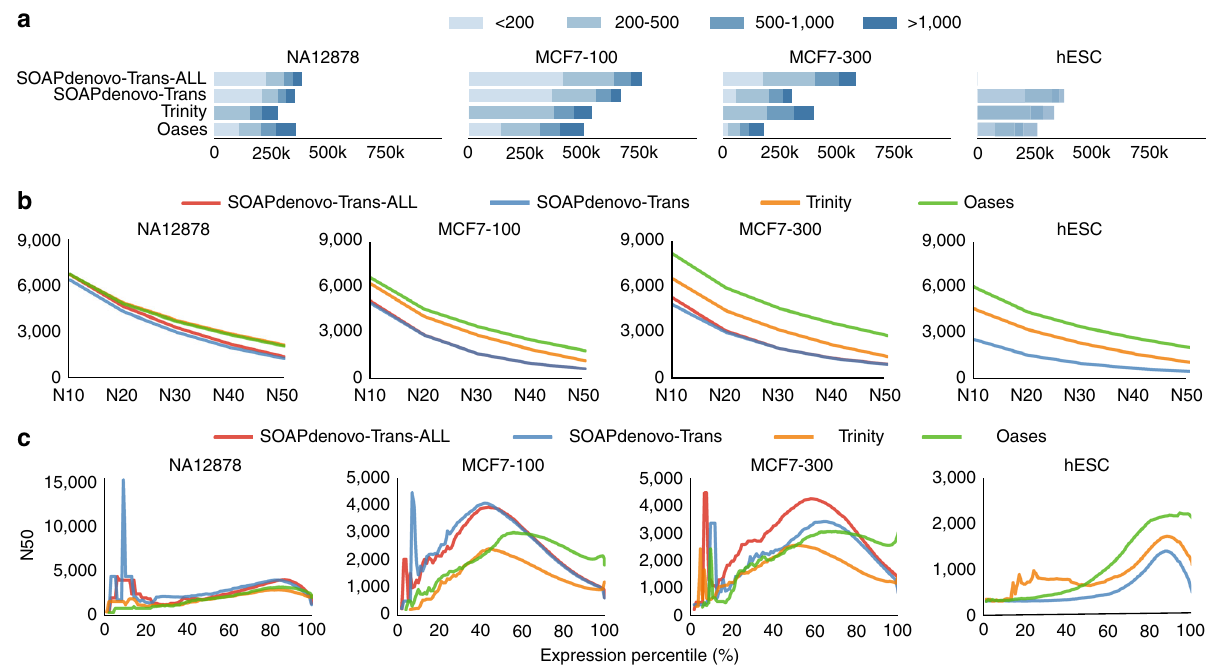
Fig. 4 Performance of different de novo transcriptome assembly techniques. a Distribution of transcript length. b N10-N50 values. (Nx is the contig length for which at least x% of the assembled transcript nucleotides were found in contigs that were at least of Nx length.) c ExN50 value at different expression percentiles. For ExN50, the N50 statistic was computed at percentile x, for only the top most highly expressed transcripts that represent x% of the total normalized expression data. Expression values were measured using